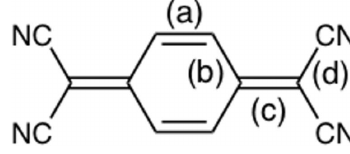
Figure 2 Bonds in TCNQ used to estimate the degree of CT, (cid:3) .